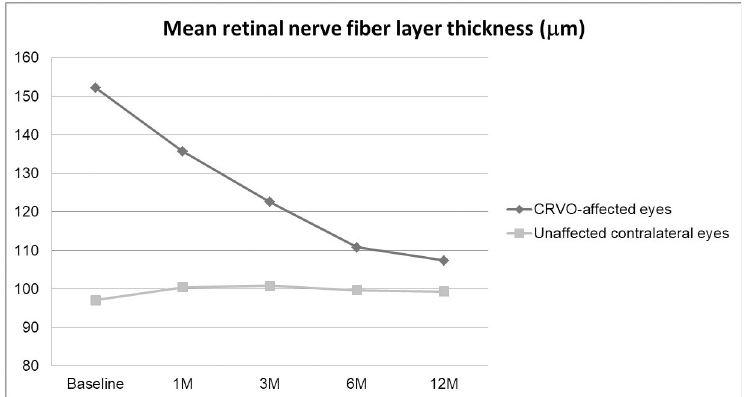
Fig 4. Changes in mean peripapillary choroidal thickness (PCT) in central retinal vein occlusion (CRVO)-affected eyes and unaffected contralateral eyes. The mean PCT was not significantly different between the CRVO-affected eyes and the contralateral eyes at each follow-up point (P = 0.314 at baseline; P = 0.782 at 1 month; P = 0.815 at 3 months; P = 0.693 at 6 months; and P = 0.343 at 12 months).